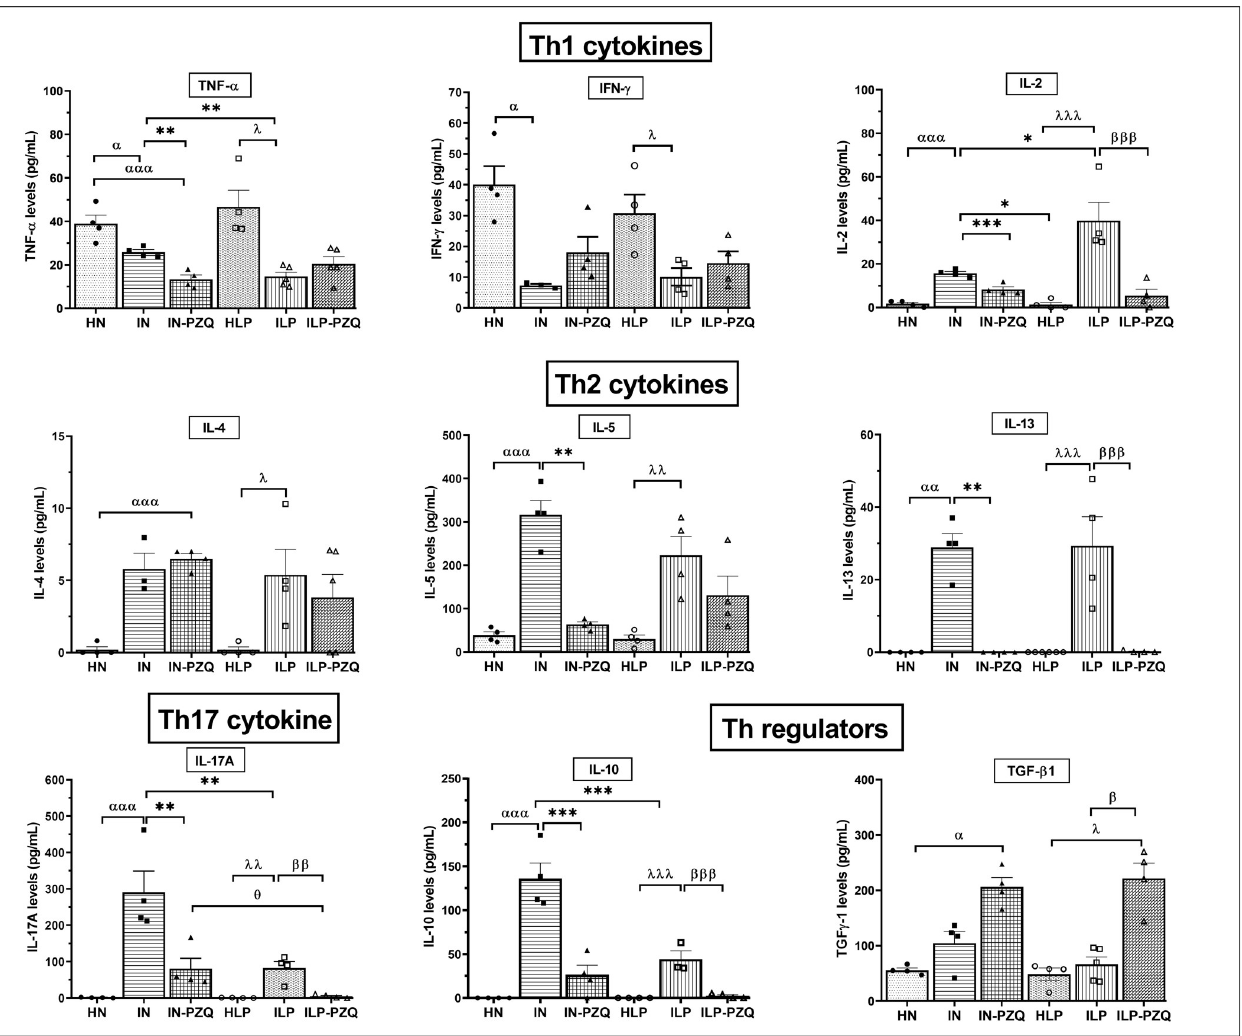
Fig 8. Effects of praziquantel treatment on cytokines production of Schistosoma mansoni -infected mice receiving a low-protein diet. Data are expressed as mean ± SEM (n = 4–8). Group HN: healthy mice receiving a standard diet; group IN: infected-untreated mice receiving a standard diet; group IN-PZQ: infected mice receiving a standard diet and treated with praziquantel; group HLP: healthy mice receiving a low-protein diet; group ILP: infected-untreated mice receiving a low-protein diet; group ILP-PZQ: infected mice receiving a low-protein diet and treated with praziquantel. ANOVA followed by Turkey multiple comparison test. α P < 0.05; αα P < 0.01; ααα P < 0.001: values are significantly different from healthy mice receiving a standard diet (group HN). � P < 0.05; �� P < 0.01; ��� P < 0.001: values are significantly different from infected-untreated mice receiving a standard diet (group IN). λ P < 0.05; λλ P < 0.01; λλλ P < 0.001: values are significantly different from healthy mice received a low-protein diet (group HLP). β P < 0.05; ββ P < 0.01; βββ P < 0.001: values are significantly different from infected-untreated mice receiving a low-protein diet (group ILP). θ P < 0.05: values significantly different from infected mice receiving a standard diet and treated with praziquantel at the dose of 100 mg/kg for 5 consecutive days (group IN-PZQ).